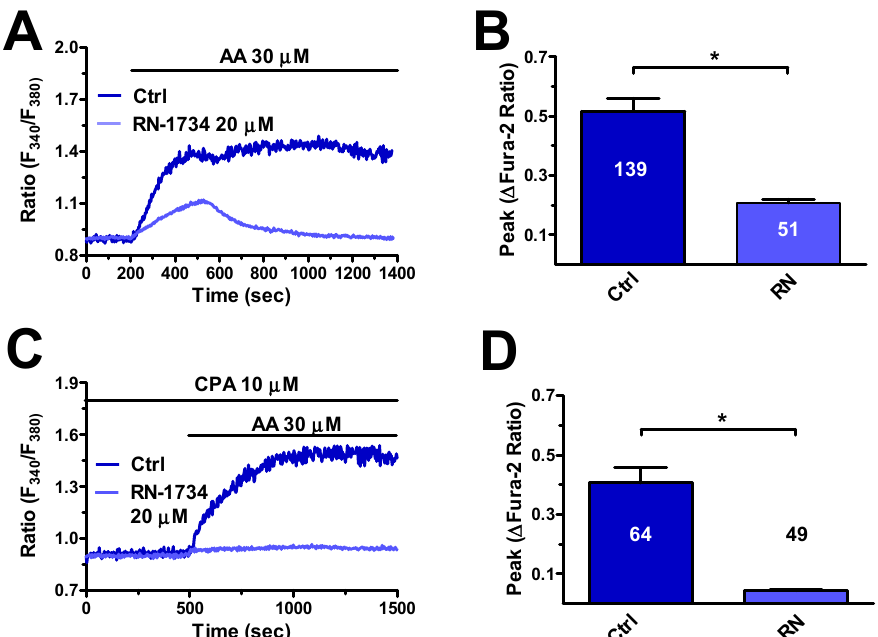
Figure 6. TRPV4 mediates arachidonic acid-induced extracellular Ca 2 + influx in hCMEC / D3 cells. ( A ) Intracellular Ca 2 + response to AA (30 µ M) recorded in the presence and in the absence of RN-1734 (20 µ M, 20 min). ( B ) Mean ± SE of the amplitude of AA-evoked Ca 2 + influx in the absence and in the presence of RN-1734 (RN). The asterisk indicates p < 0.05. ( C ) AA (30 µ M) evoked an increase in the [Ca 2 + ] i in the presence of extracellular Ca 2 + upon 30 min treatment with CPA (10 µ M) to deplete the ER Ca 2 + store and fully activate store-operated Ca 2 + influx (SOCE). AA-evoked Ca 2 + influx was abolished by pretreating the cells with RN-1734 (20 µ M, 20 min). ( D ) Mean ± SE of the amplitude of AA-induced intracellular Ca 2 + signals in the absence and in the presence of RN-1734 (RN) upon SOCE activation with CPA (10 µ M). The asterisk indicates p < 0.05.